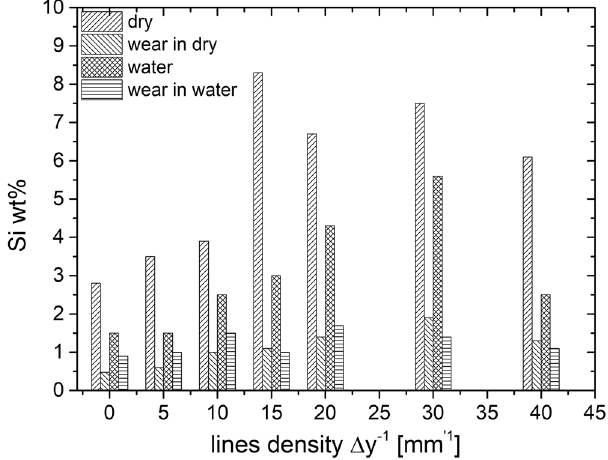
Figure 7. Si wt% before and after wear analysis in dry and water environments for unprocessed and laser- textured surfaces as determined by EDS